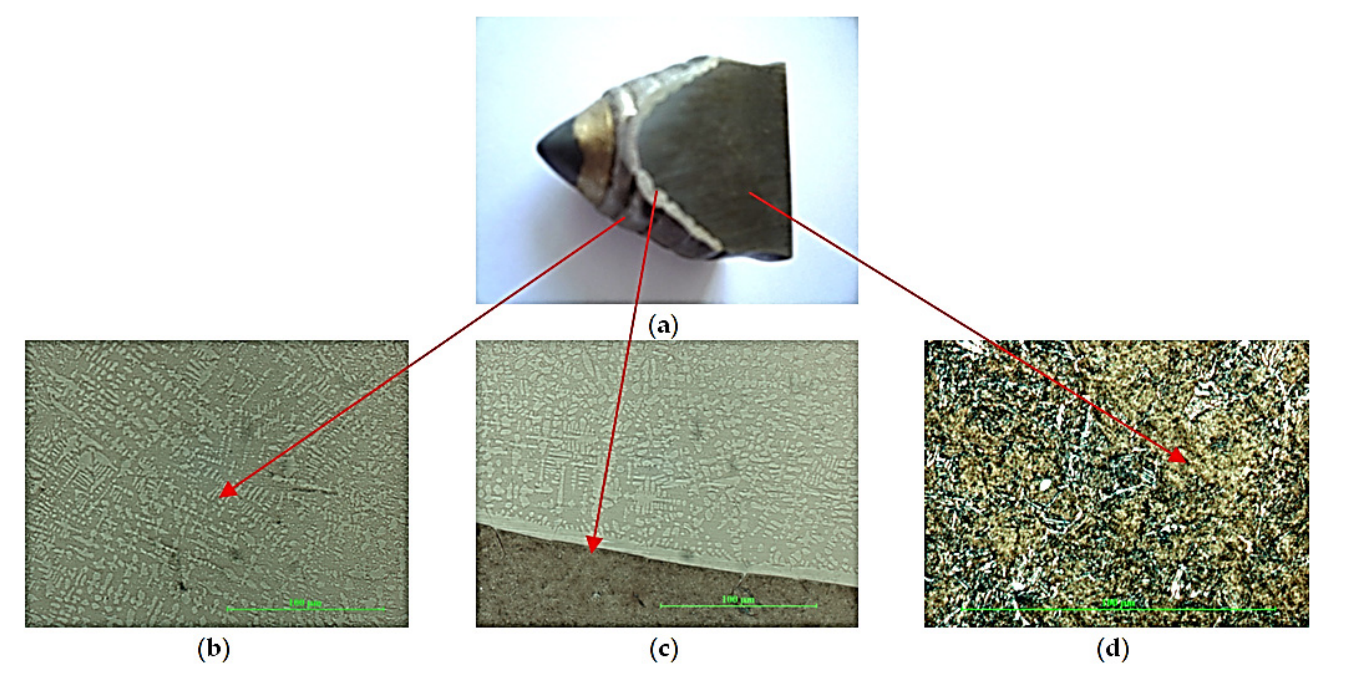
Figure 6. Views of the macro- and microstructural analyses of the powder and laser metal deposition area: ( a ) milling tooth macrostructure; ( b ) deposited material (DM), 100× magnification; ( c ) transition area (TA), 50× magnification; ( d ) base material (BM), 50× magnification.